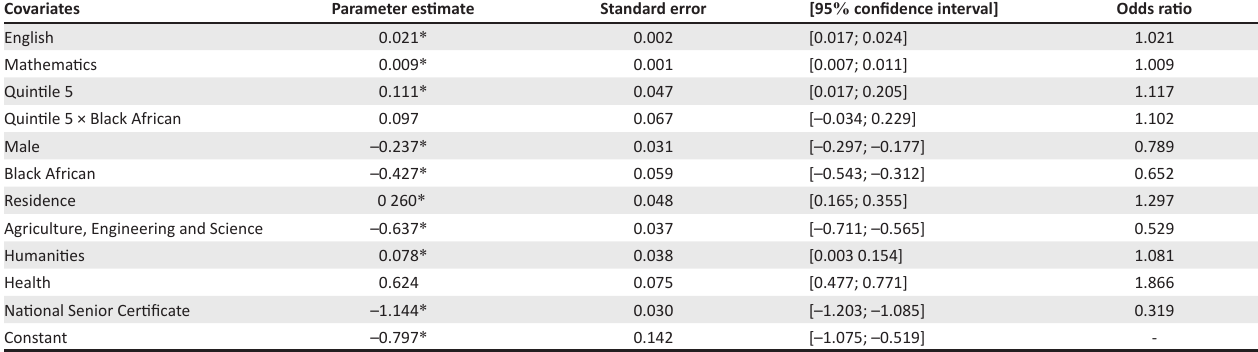
TABLE 6: Parameter estimates associated with covariates affecting the probability of graduation at the university. Covariates Parameter estimate Standard error [95 % confidence interval] Odds